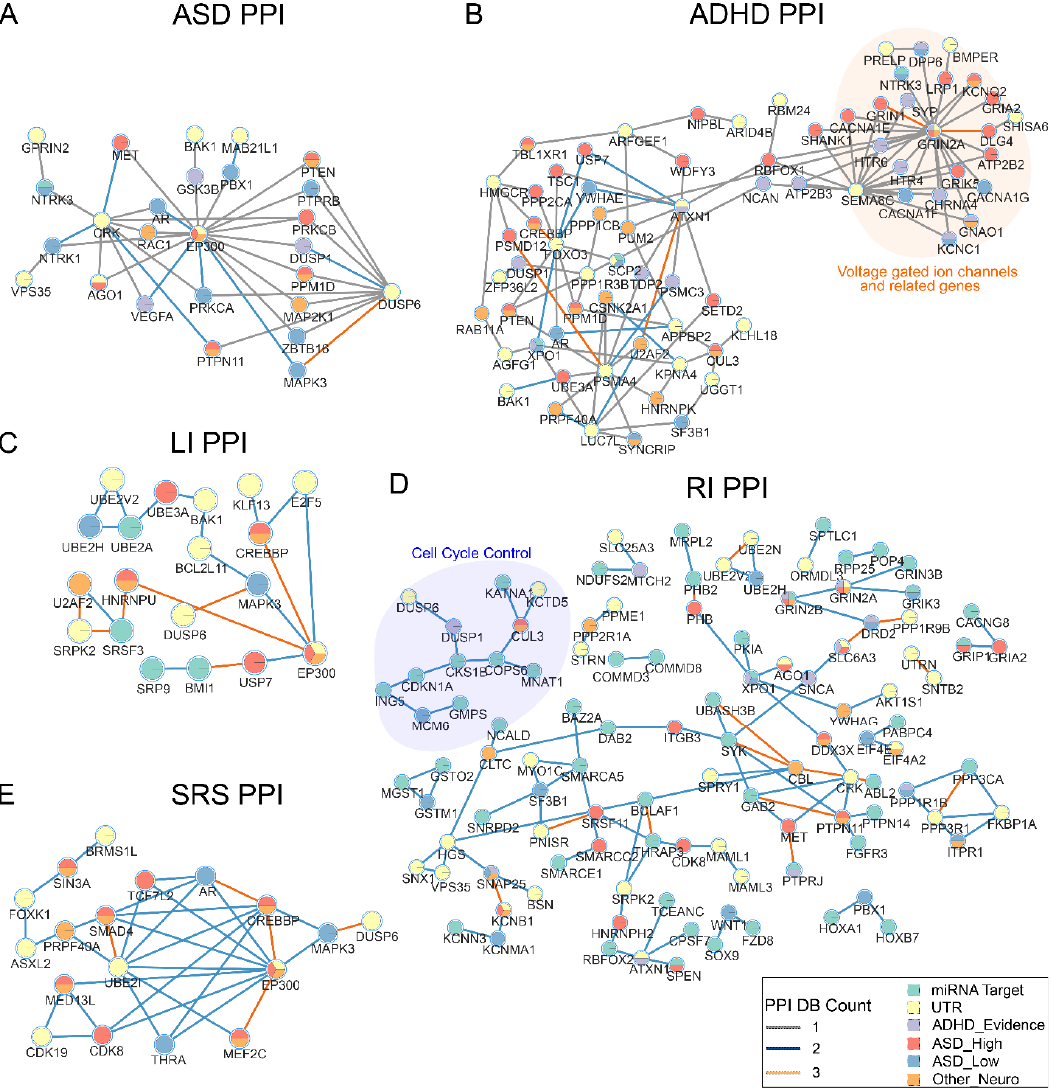
Figure 5. Candidate gene interaction network with known NDD genes. Known genes